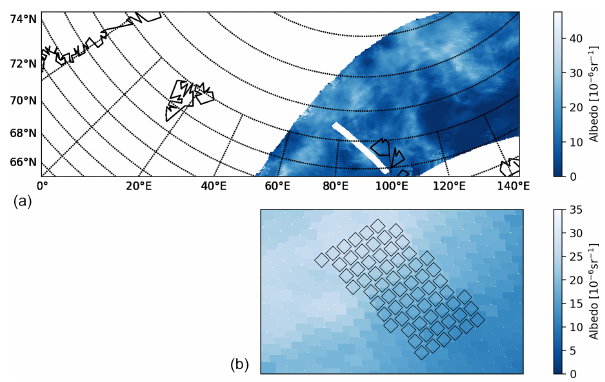
Figure 1. Example orbit showing a CIPS/OSIRIS coincidence on a polar map plot for CIPS orbit 50777 and OSIRIS orbit 17098. Panel (a) shows the CIPS orbit strip. The white line on top of the CIPS orbit strip indicates the overlapping ∼ 660 CIPS pixels in the CV. Each CV is composed of ∼ 10 CV elements. Panel (b) shows an example of only those 66 pixels contained within one CV element.